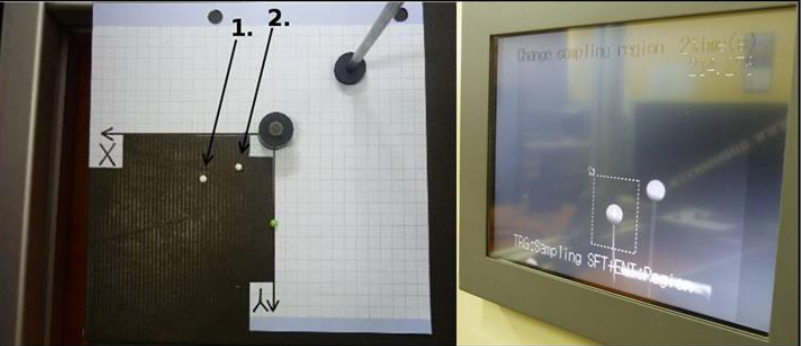
Figure 6. Initial calibration of CCD cameras.